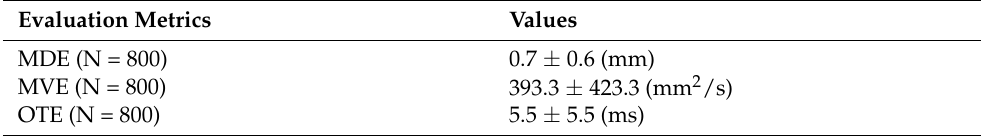
Table 7. Evaluation results of MDE, MVE, and OTE (N: the number of motion images, mean ± std). Evaluation Metrics